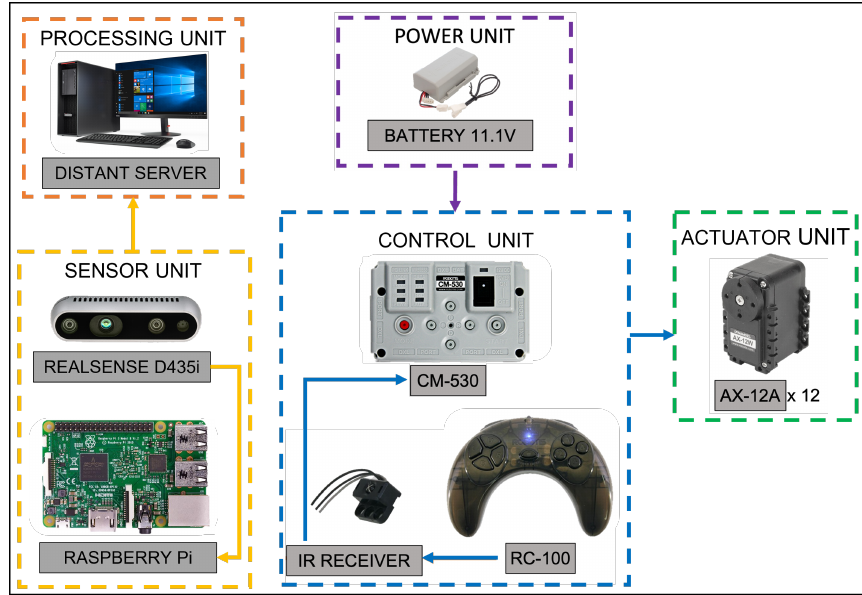
Figure 6. System